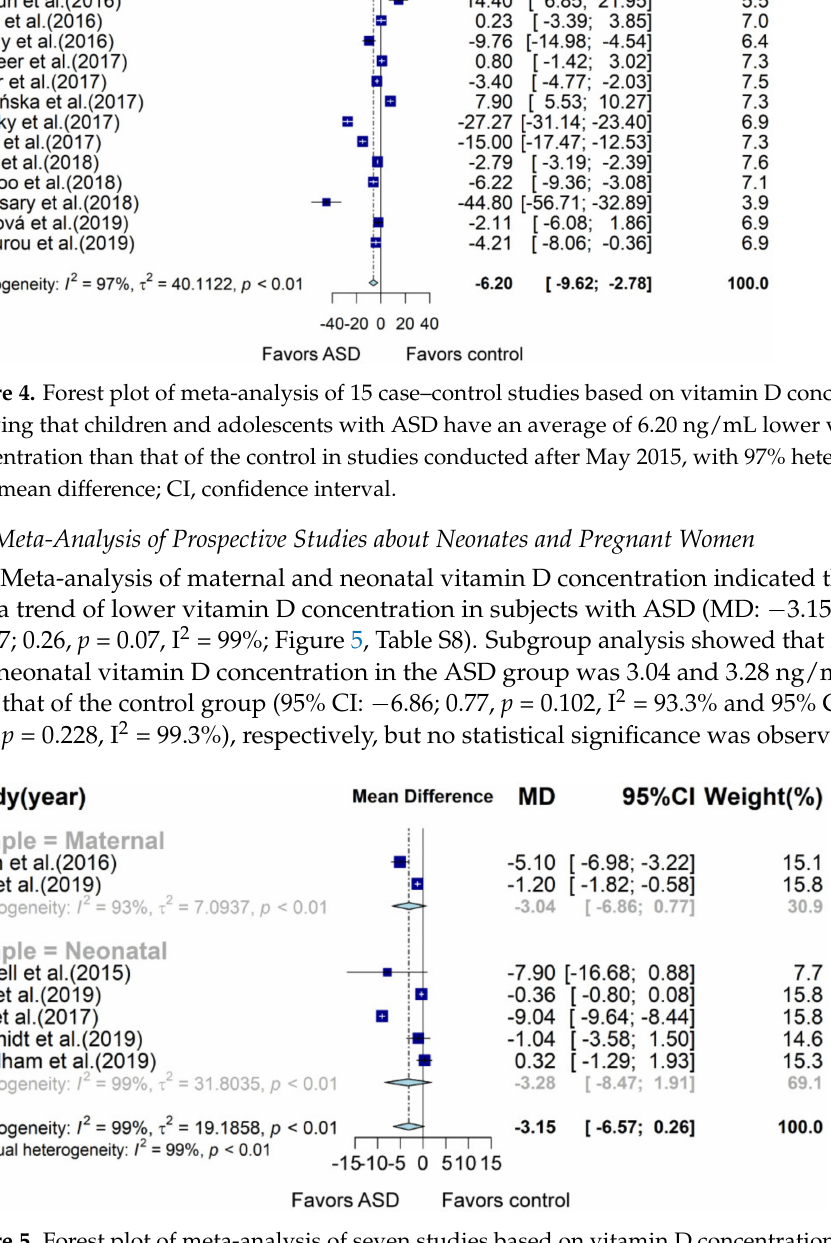
Figure 5. Forest plot of meta-analysis of seven studies based on vitamin D concentration. Overall, children with ASD tend to have 3.15 ng/mL lower neonatal or maternal vitamin D concentration than that of children without ASD, with 97% heterogeneity. MD, mean difference; CI, confidence